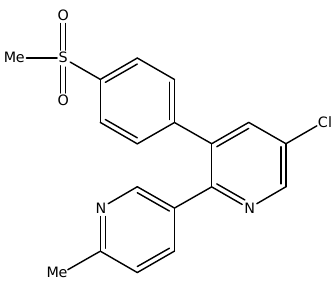
Figure 1. Chemical structure of Etoricoxib (5-Chloro-2-(6-methyl pyridine-3yl) 3-(4-methyl sulfonyl phenyl) pyridine (Etorocoxib))